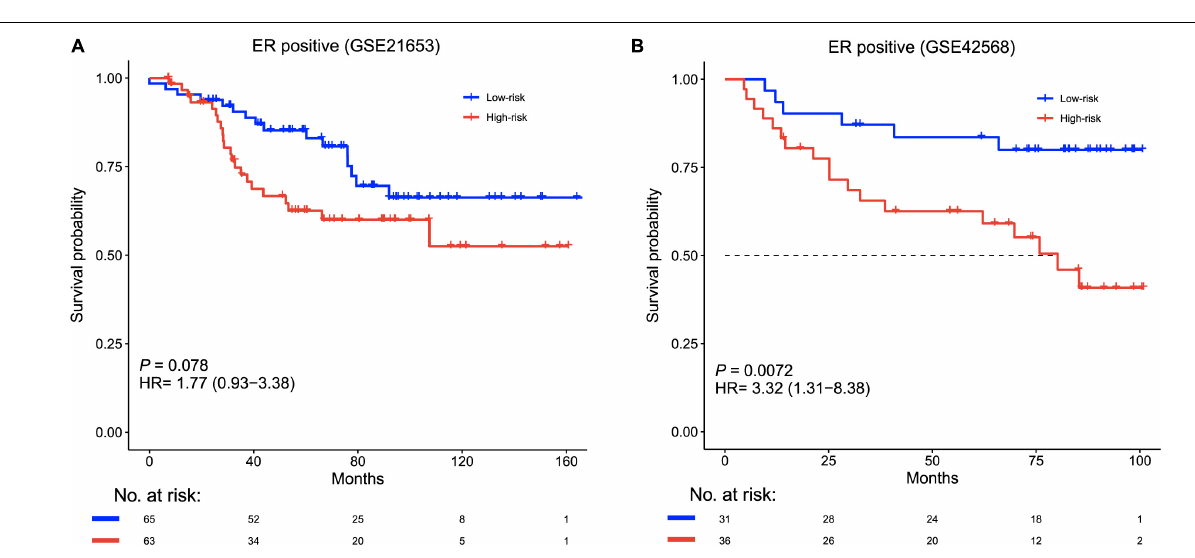
FIGURE 4 | Survival analysis of ER-positive patients based on the six-lncRNA signature. Kaplan–Meier survival curves for ER-positive patients in (A) GSE21653 ( n = 128) and (B) GSE42568 ( n =